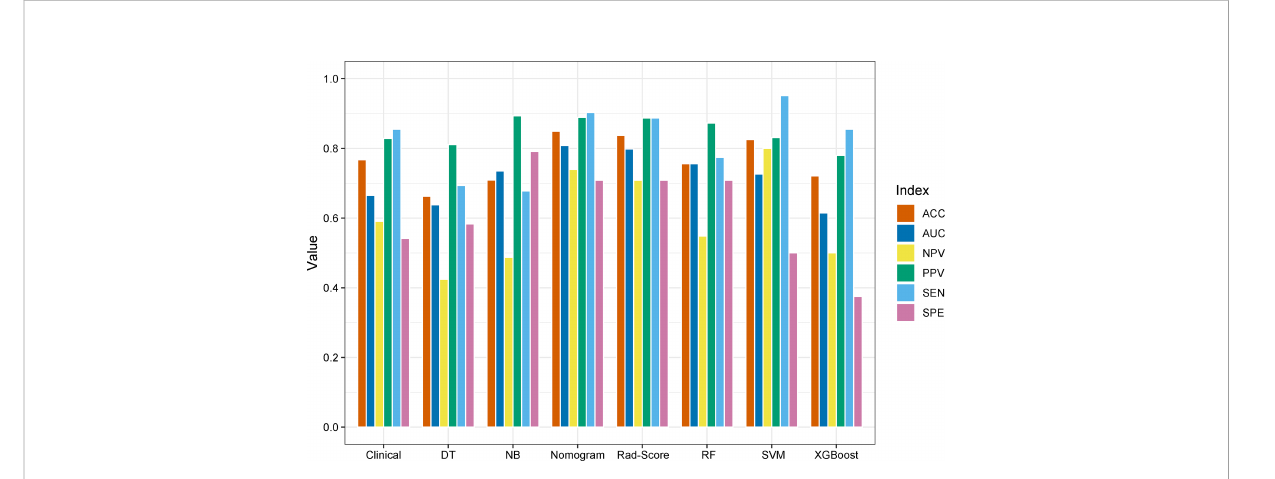
FIGURE 11 Bar plot of the performances of the eight prediction models in the test